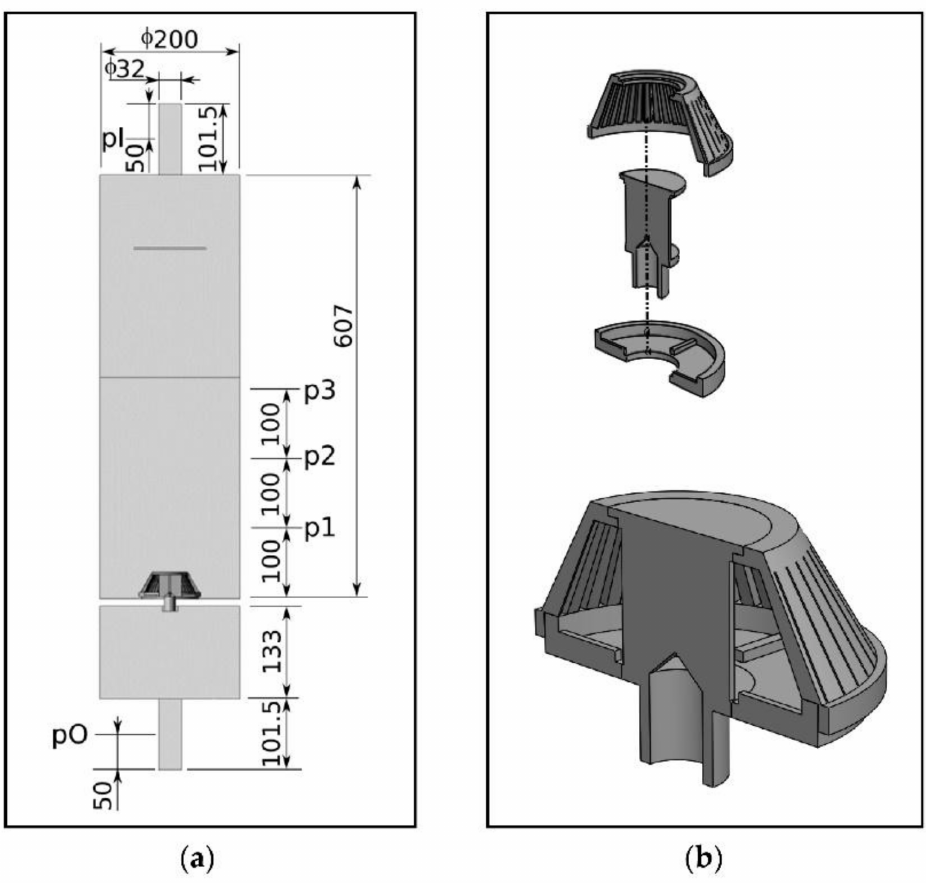
Figure 1. ( a ) Main dimensions of the laboratory filter analyzed (mm); ( b ) Half section view of the pod type underdrain and its